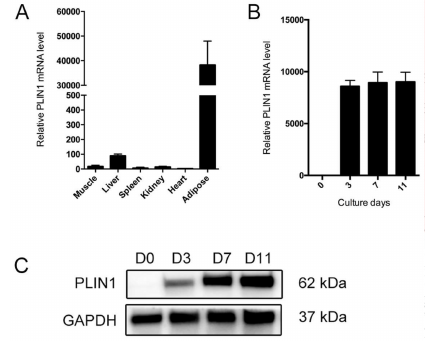
Figure 6. Expression patterns of PLIN1 gene in different tissues and stages of adipocyte differentiation. ( A ) Real-time quantitative reverse transcription polymerase chain reaction (qRT-PCR) analysis for PLIN1 messenger RNA (mRNA) expression levels in porcine adipose and other tissues; ( B ) qRT-PCR analysis for PLIN1 Mrna; and ( C ) Western blotting analysis for PLIN1 protein expression levels at 0, 3, 7, and 11 d after adipocyte differentiation. All data are presented as mean ± standard error (SE); n =